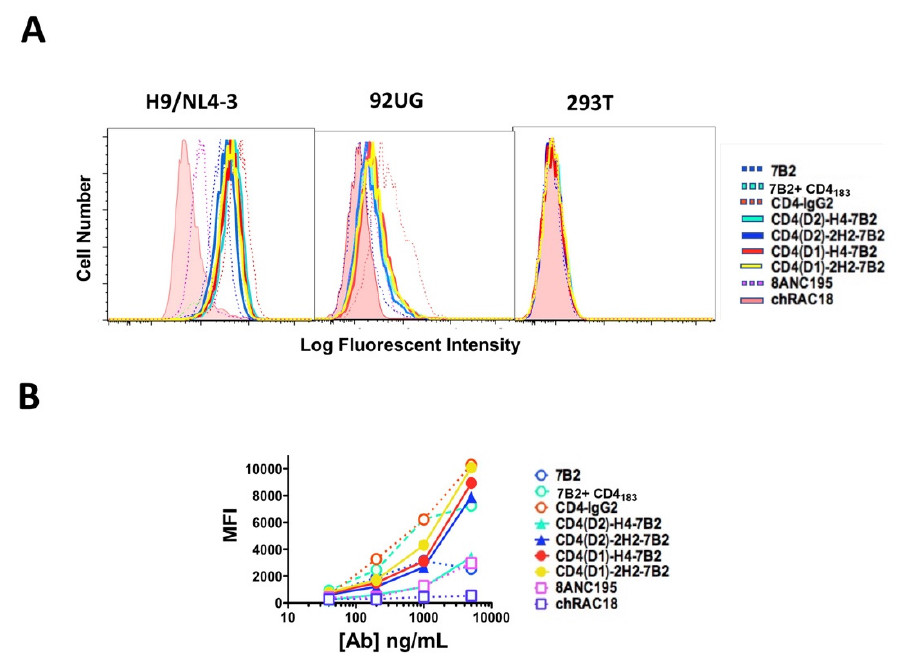
Figure 3. Binding of Abs and Ig-adhesins to Env-expressing cells. Binding of the panel was detected by secondary immunofluorescence and flow cytometry. For each sample, 10,000 H9/NL4-3, 293/92UG, or 293T cells were evaluated ( A ). Histograms of analyses performed with 1 µg/mL of mAb or Ig-adhesin. Cells were first gated based on FSC and SSC, before analyzing for fluorescence. Binding of the isotype control is shown as the solid pink histogram ( B ). Titration curves of binding to NL4-3. For each concentration, the mean fluorescent intensity and SEM are shown. When no error bars are visible, they are smaller than the symbol. The data shown are representative of >5 unique experiments.